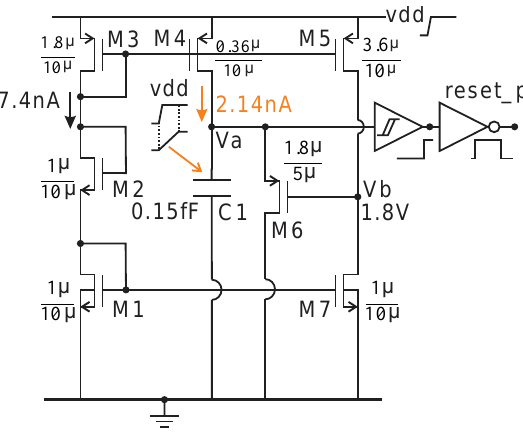
Figure 17. Power-on-reset circuit for AFE and ADC.